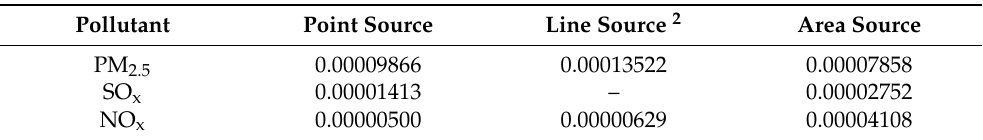
Table 2. The effect of a one-ton pollution reduction for each pollutant on the concentration from different sources 1 .